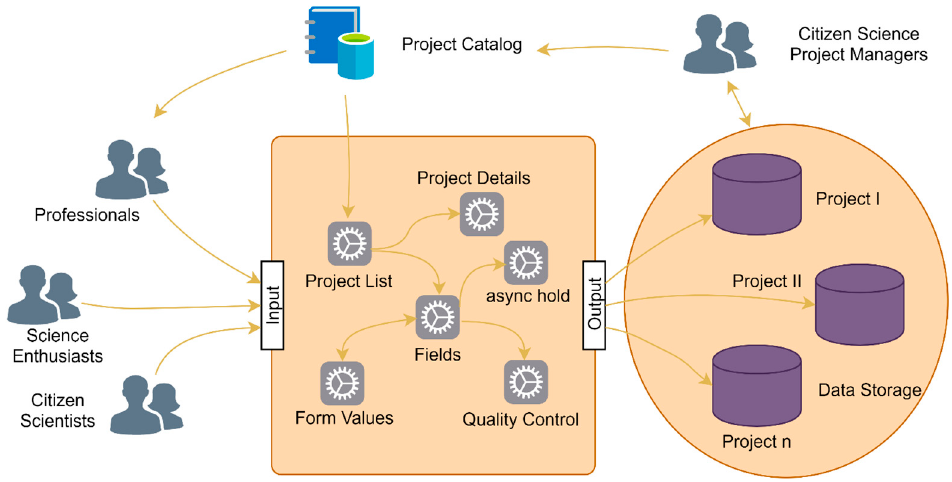
Figure 4. Citizen Science Module Design.